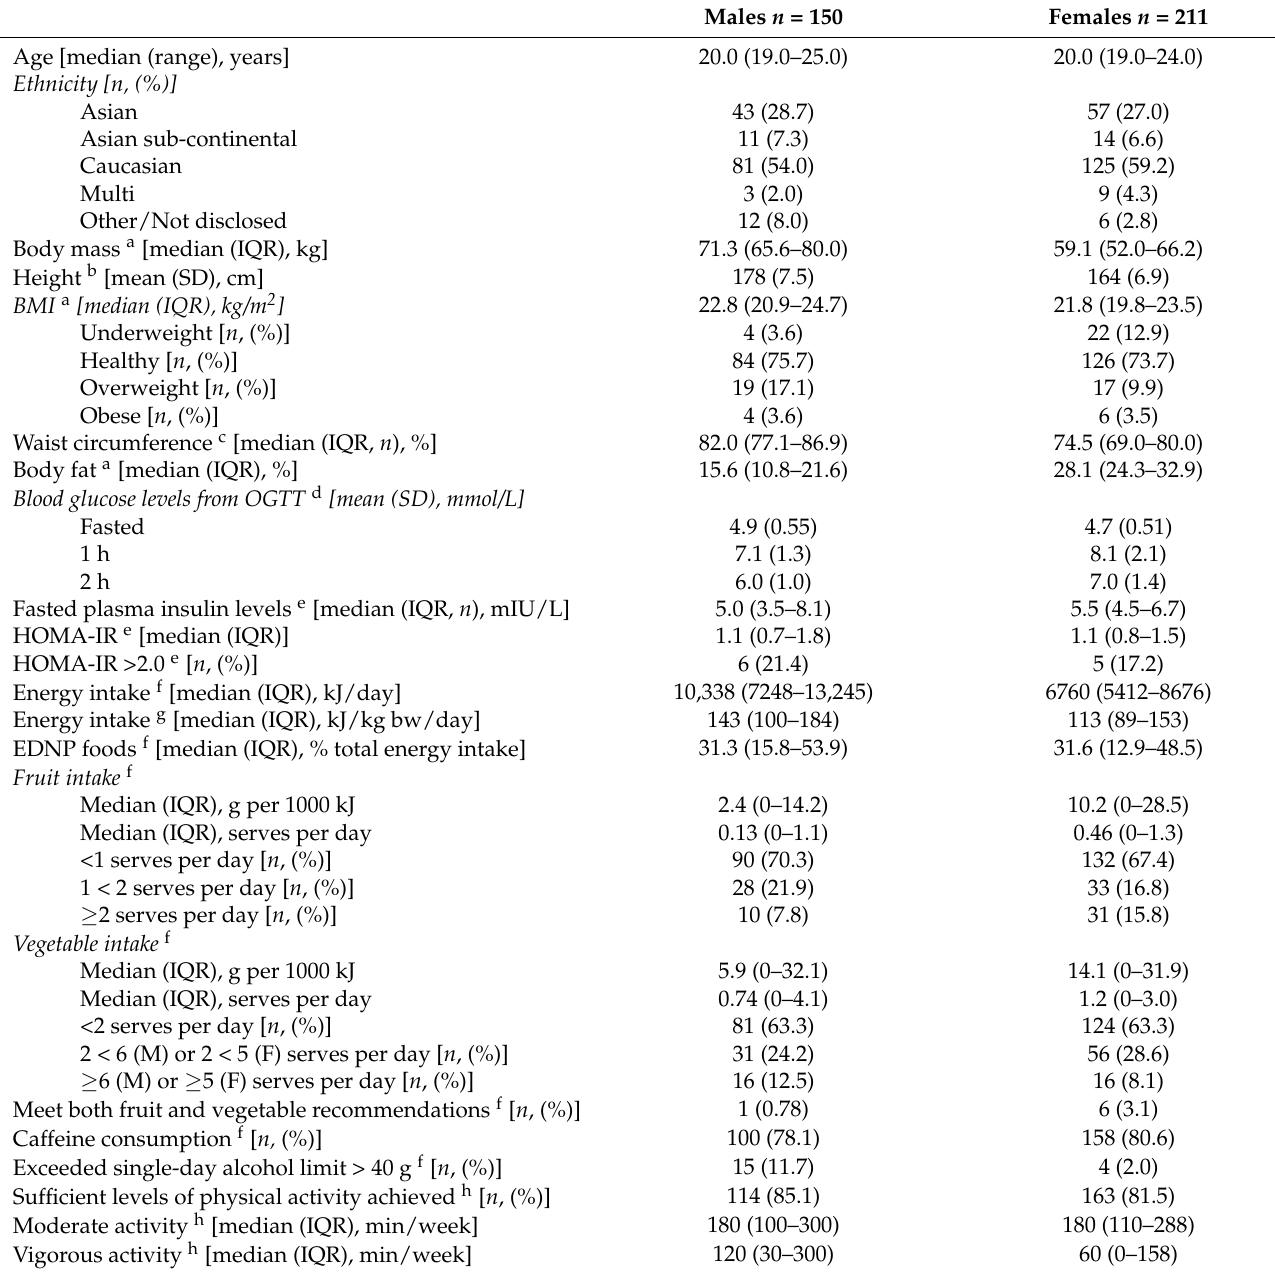
Table 1. Demographic, metabolic, diet, and physical activity characteristics of